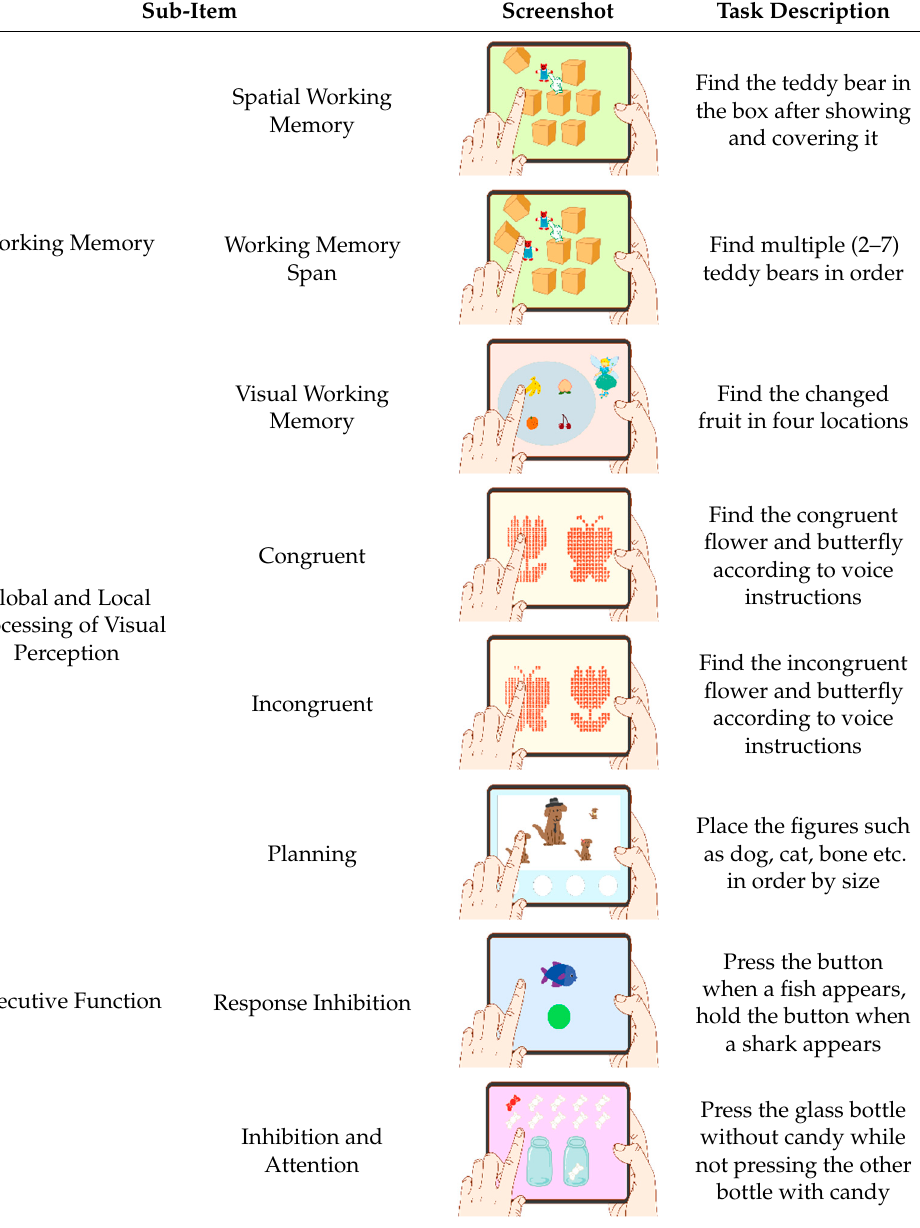
Table 5. Cognitive function assessment.